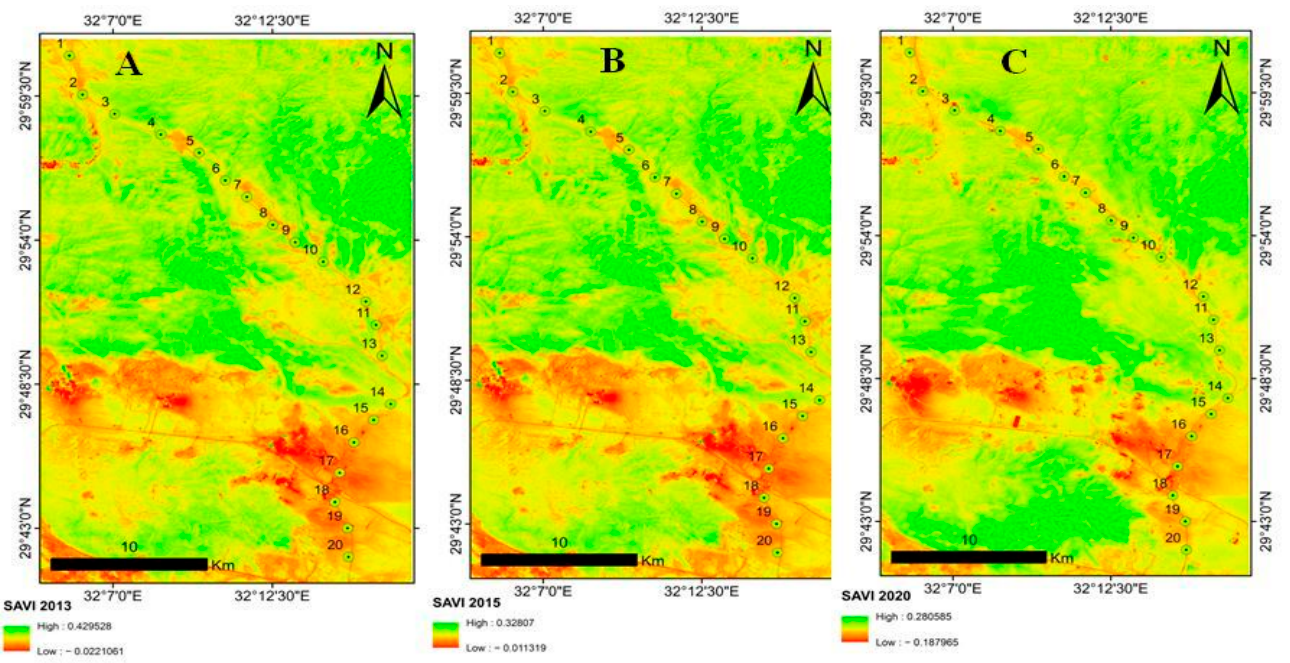
Figure 8. SAVI maps for 2013 ( A ), 2015 ( B ), and 2020 ( C ).